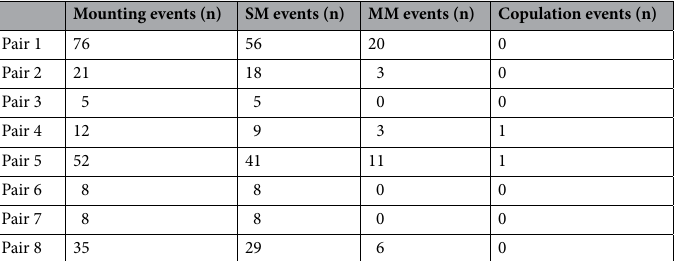
Table 1. Total number of intrapair mounting ( SM single mounting, MM multiple mounting) and copulation events recorded in each monitored porcupine pair.